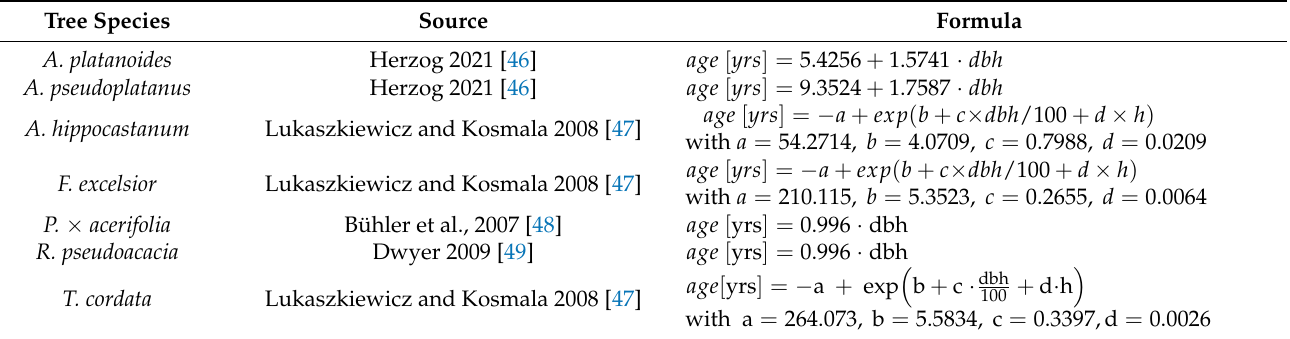
Table 2. Equations and parameters for the calculation of tree age for specific tree species. Sources of the formulas are indicated for every tree species; for R. pseudoacacia we applied the formula developed for Gleditschie by Dwyer (2009).